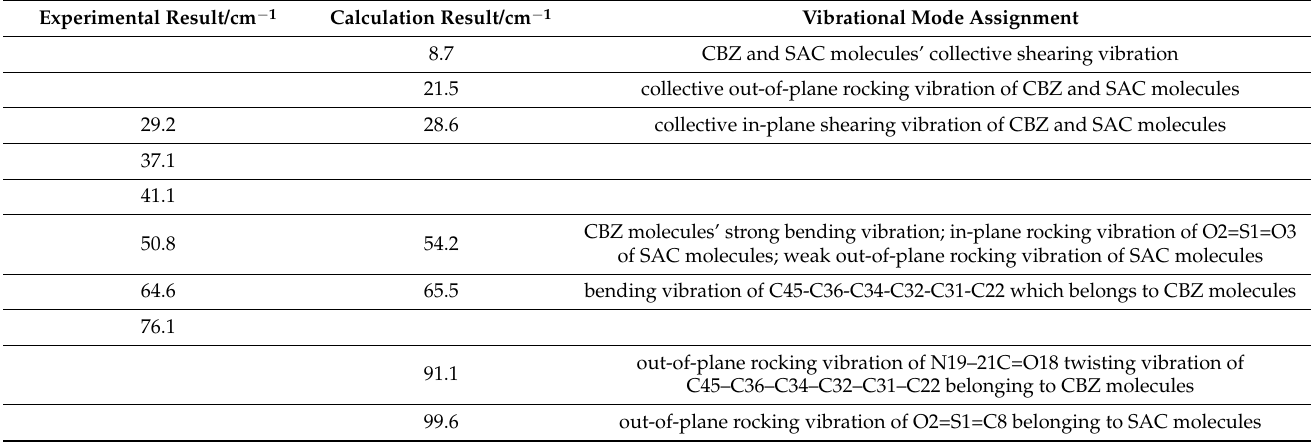
Table 4. Vibrational mode assignment for low-wavenumber Raman characteristic peaks of the CBZ-SAC